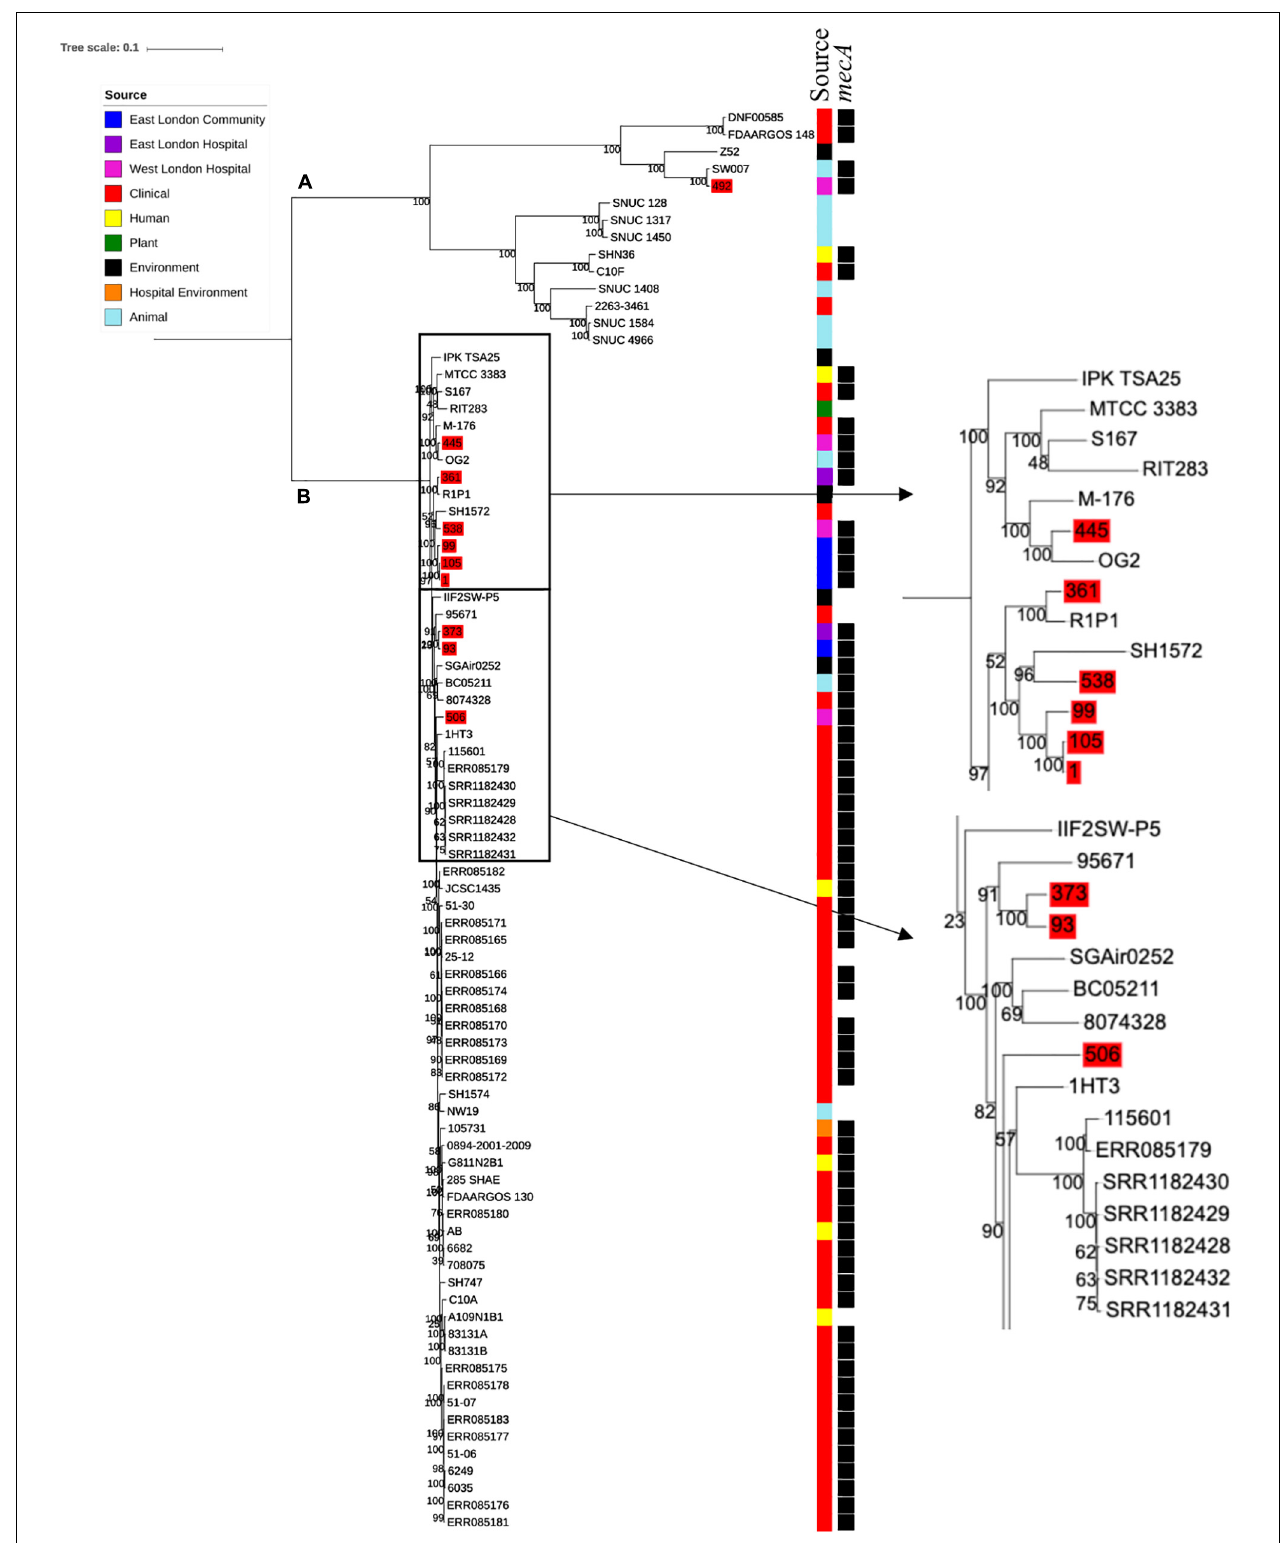
FIGURE 3 | Core SNP maximum likelihood phylogenetic tree of 83 S. haemolyticus , including isolates recovered from public settings in East and West London and those obtained from the ENA. (A,B) represent the two most distinct clades. Isolates recovered from public settings in London are highlighted in red.